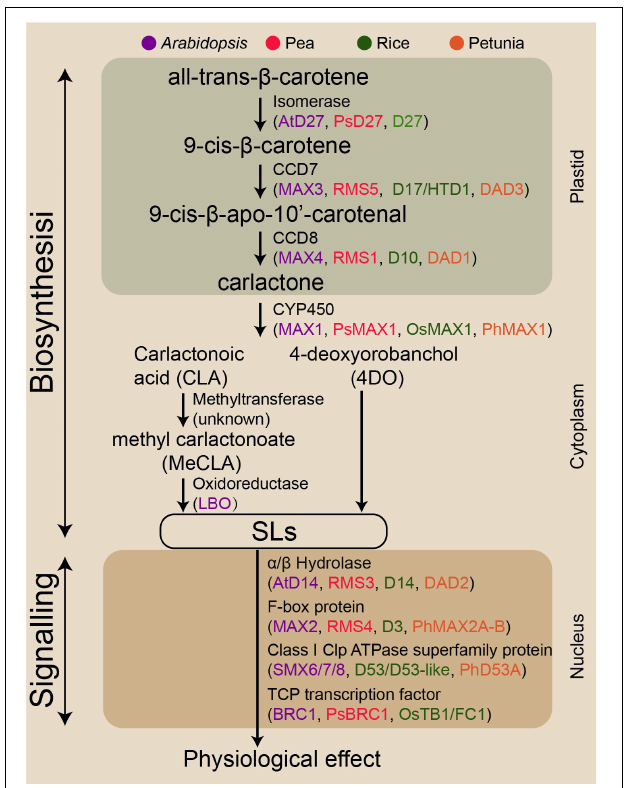
FIGURE 1 | Genes encoding the enzymes involved in SL biosynthesis and signalling pathway identified in the four model species.